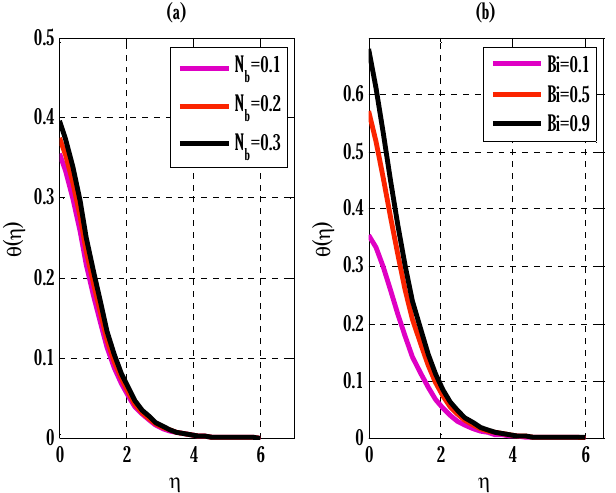
Figure 5. Vari ation of Brownian motion parameter and Biot number on temperature Figure 5. Variation of Brownian motion parameter and Biot number on temperature profile using profile using 𝑁 = 30,𝛽 = 3,𝜆 = 0.1,𝐹 (cid:3045) = 0.1,𝑀 = 0.1,𝐸 (cid:2869) = 0.01,𝑁 (cid:3047) = 0.1,𝐸 (cid:3030) = 0.3,𝑅 (cid:3031) = N = 30, β = 3, λ = 0.1, F r = 0.1, M = 0.1, E 1 = 0.01, N t = 0.1, E c = 0.3, R d = 0.1, P r = 1.7, 0.1,𝑃 (cid:3045) = 1.7,𝑆 (cid:3030) = 1.5,and 𝛾 = 0.1. ( 𝐚 ) 𝐵𝑖 = 0.1, ( 𝐛 ) 𝑁 (cid:3029) = 0.1 . S c = 1.5, and γ = 0.1. ( a ) Bi = 0.1, ( b ) N b = 0.1.